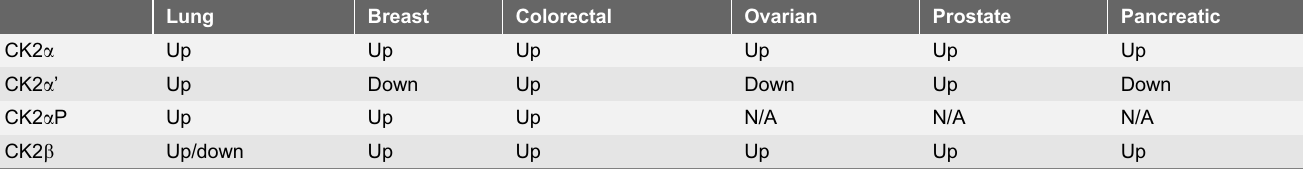
Table 8. Overall trends of CK2 mRNA expression levels in the 6 types of